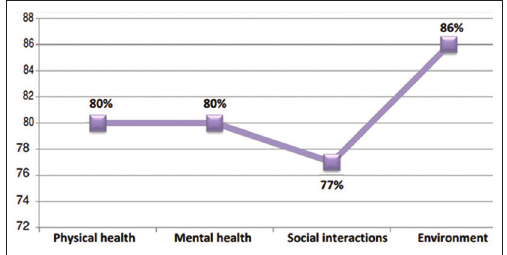
FIGURE 1. Quality of life (QOL) presented as a value of median with corresponding IQR. The value of QOL for total number of the surveyed respondents was 80% MSV with IQR (73%-86%). The highest value was noted in the area of environment with a median of 86% MSV with IQR (76%-92%). The lowest value was observed in the area of social interactions 77% MSV with IQR (67%-83%).